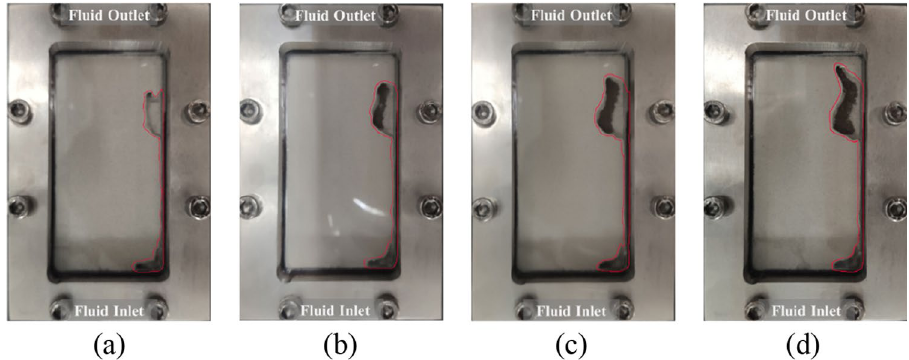
Fig. 8 The macroscopic extending performance of the sanding cav- ity of the single-branch wormhole. a The performance of the sanding cavity after the 30th second with total pressure drop 8.8 kPa; b the performance of the sanding cavity after the 180th second with total